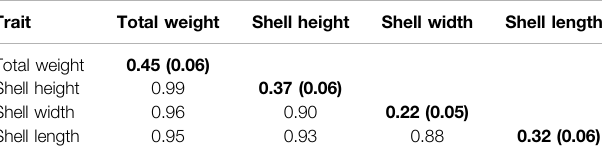
TABLE 2 | Estimates of heritability ( h 2 ) and SE on the diagonal and pairwise genetic correlations (below the diagonal) for growth-related traits in a European fl at oyster